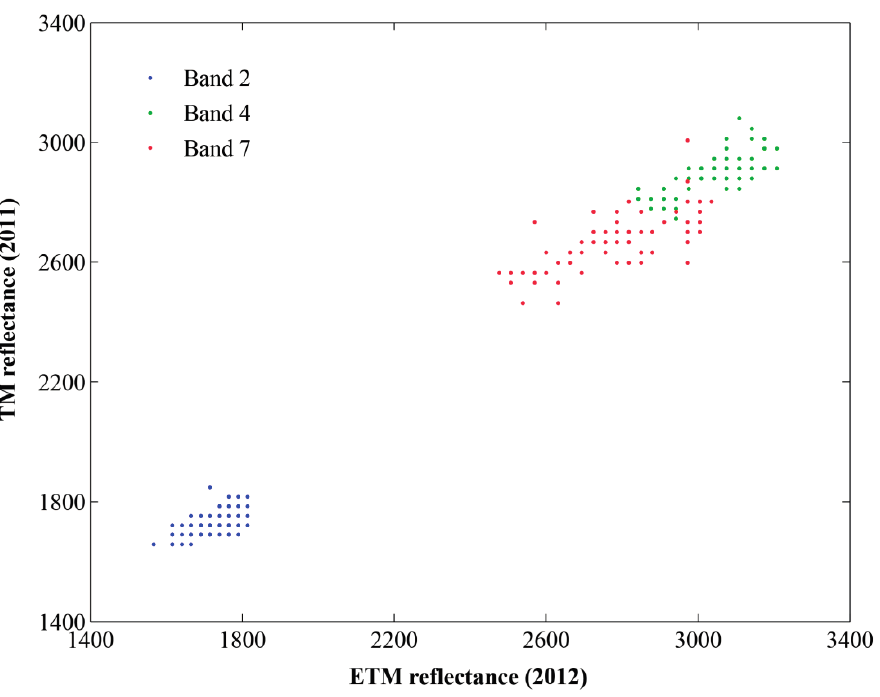
Figure 15. Statistics of the tested area for a clay-rich surface. See the location in Figure